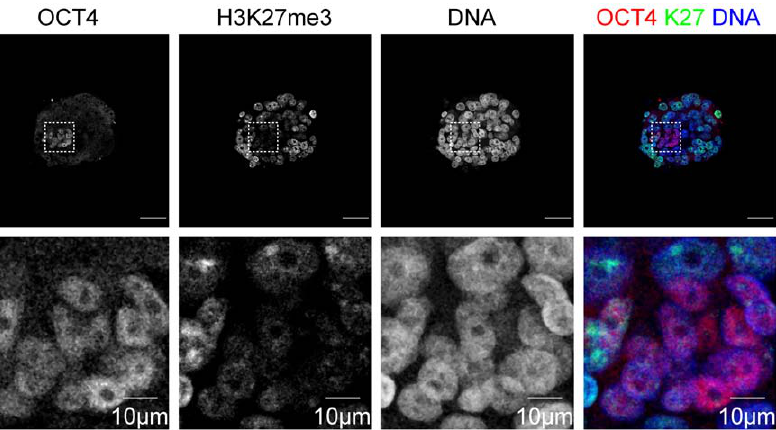
Figure 8. No accumulation of H3K27me3 on the X-chromosomes of epiblast precursors. Expression of OCT4, and H3K27me3 in human embryos that have been co-cultured with decidualized endometrial cells for 72 h. The four bottom panels are an enlargement of the indicated area in the panels directly above. Scale bars are 50 m m unless otherwise indicated.